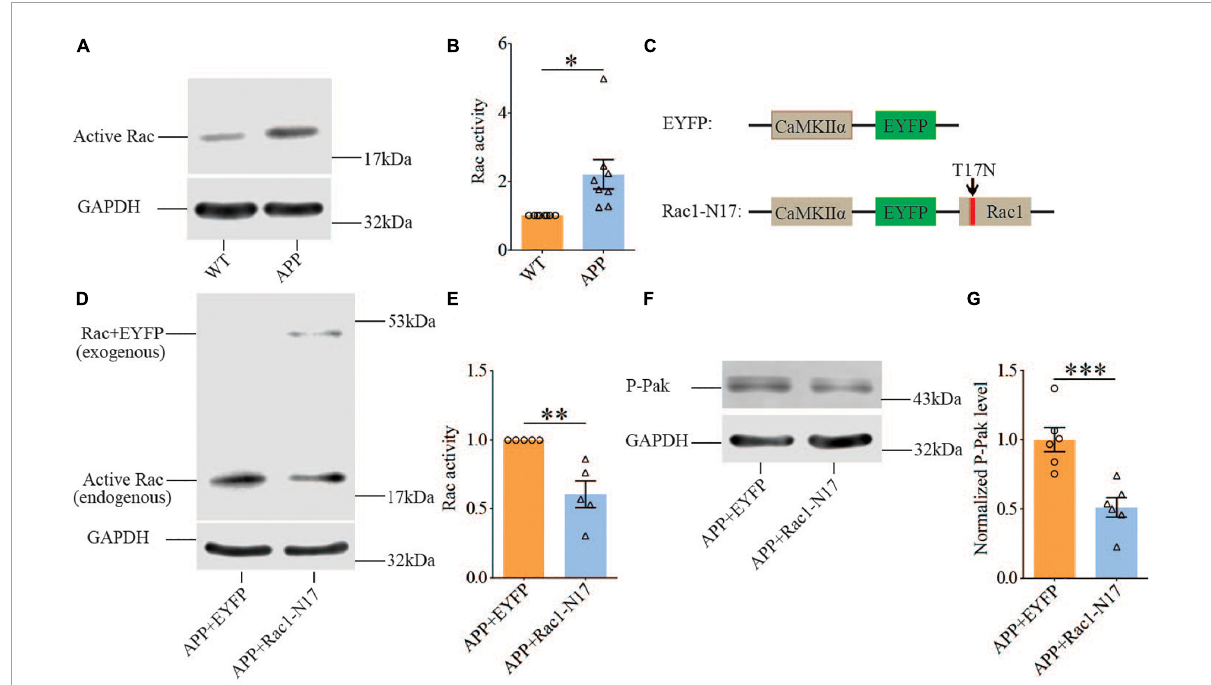
FIGURE3 Increased Rac1 activity in APP mice and its reduction by expression of Rac1-N17. Western blots of active Rac1 assay (A) and summary graphs (B) showing increased level of active form of Rac1 in ventral hippocampus in APP compared to WT mice (WT: n = 8 independent experiments from 4 animals for each group, p = 0.0127, two-tailed paired t -test). AAV virus constructs of control EYFP and Rac1-N17 (C) , western blots (D,F) , and summary graph (E,G) showing decreased level of active Rac1 ( n = 5 independent experiments from 3 animals for each group, p = 0.0335, two-tailed paired t -test) and phosphorylated active PAK1/2/3 (P-Pak) ( n = 6 independent experiments from 3 animals for each group, p < 0.001, two-tailed paired t -test) in APP mice injected with Rac1-N17 virus (APP + Rac1-N17) compared to those injected with EYFP virus. Endogenous Rac1 refers to Rac1 protein expressed by the endogenous Rac1 gene, while exogenous Rac1 refers to EGFP-Rac1 fusion protein expressed by EYFP-Rac1-N17 viral infections. * P < 0 . 05, ** P < 0 . 01, and P < 0 .